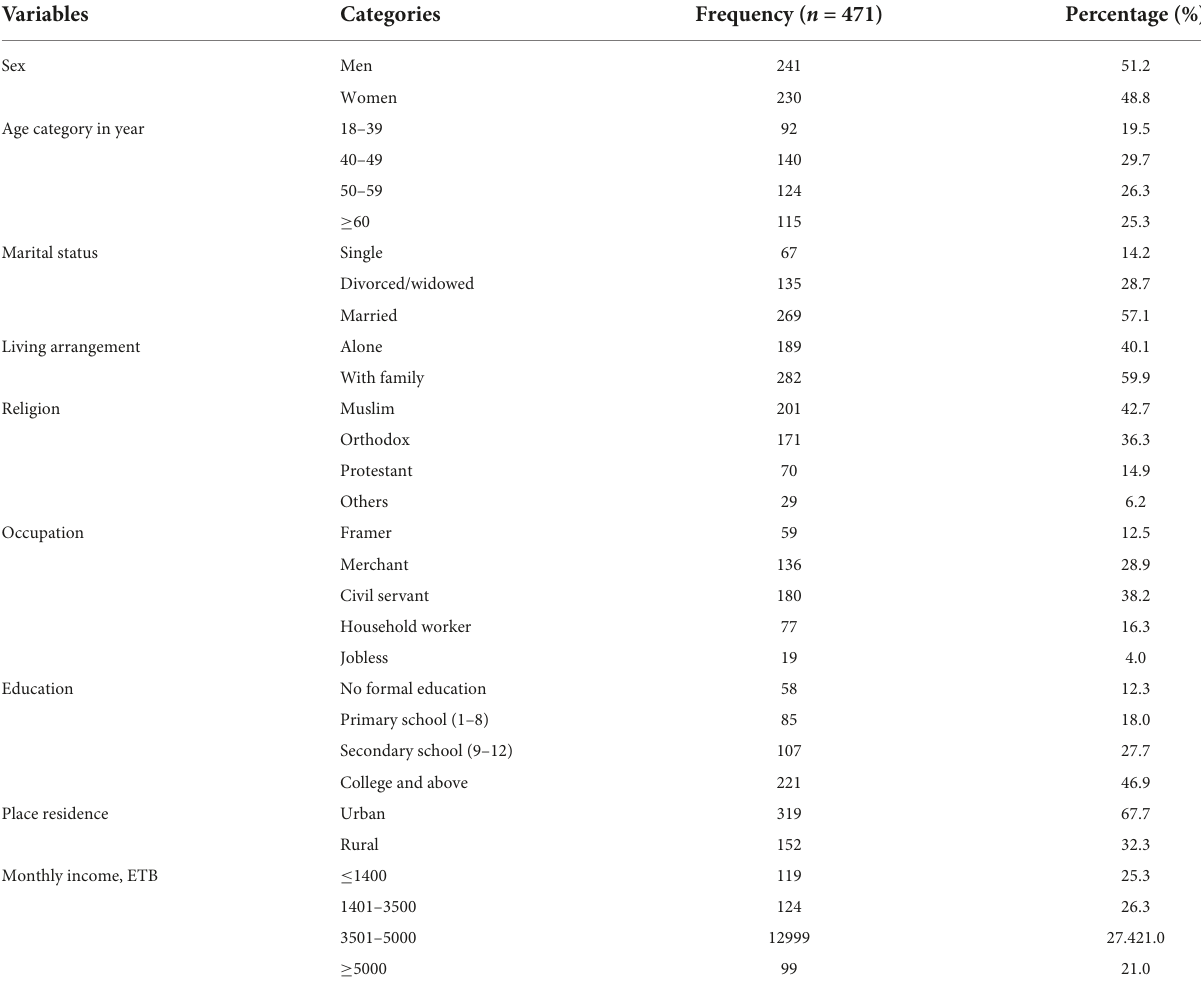
TABLE 1 Demographic information of people with hypertension on follow-up in Eastern Ethiopia ( n =